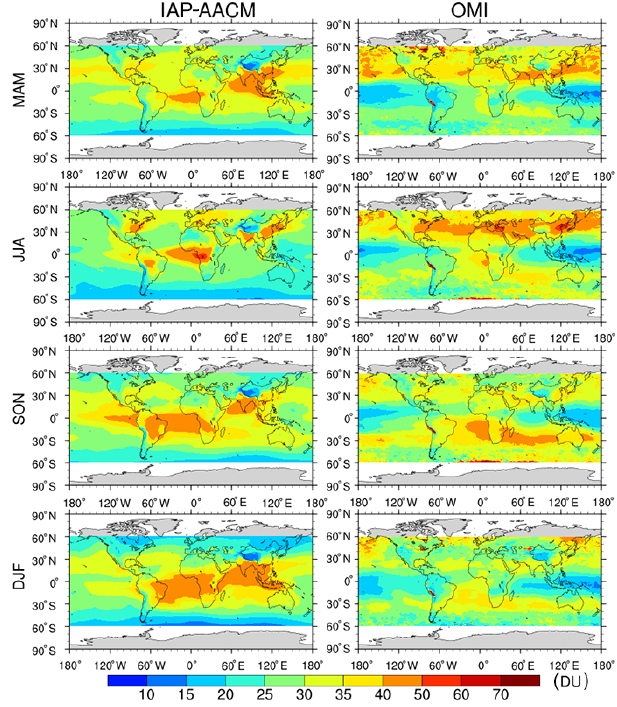
Figure 8. Seasonal mean column concentration of O 3 from IAP-AACM (left column) and OMI (right column). Seasons are defined as March–April–May (MAM), June–July–August (JJA), September–October–November (SON), and December–January– February